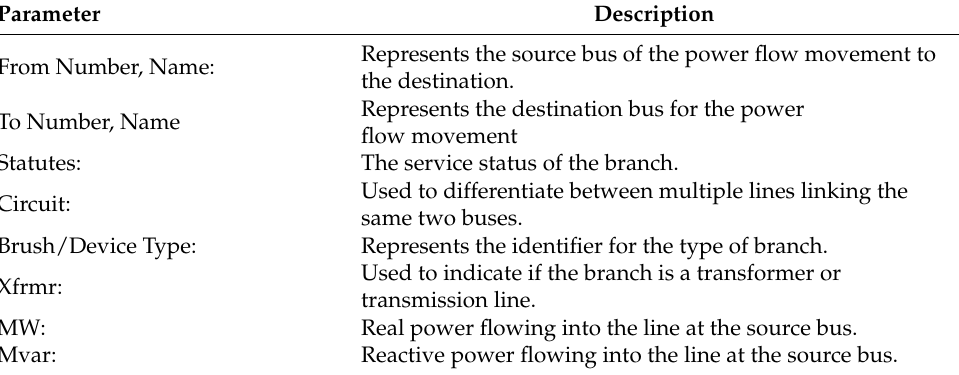
Table 5. Notations and their